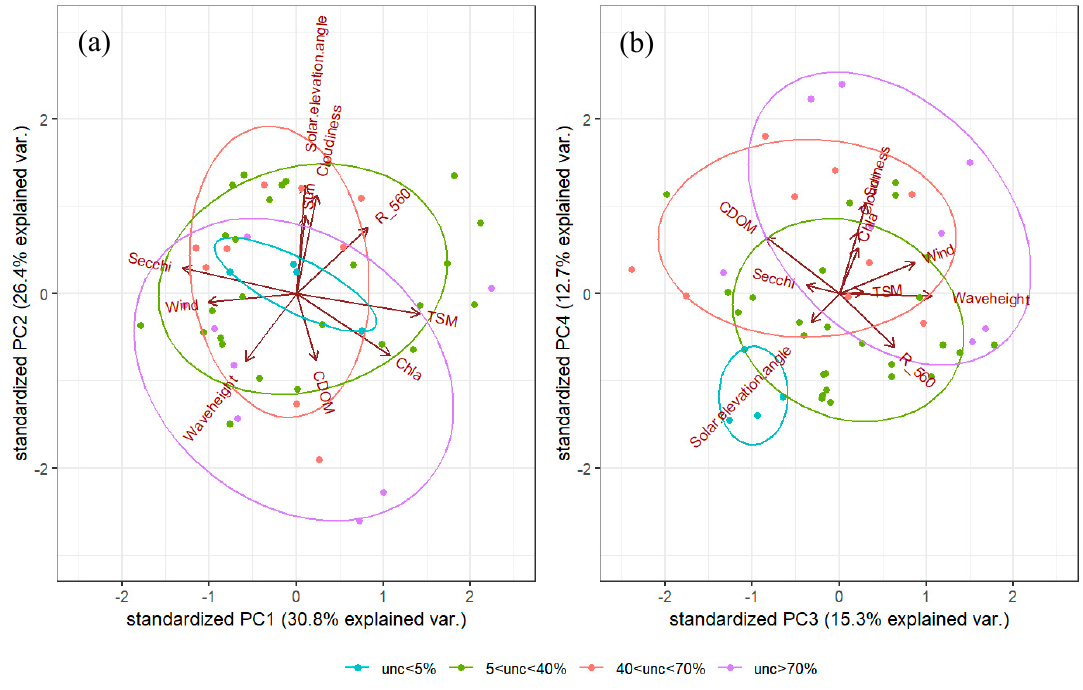
Figure 3. Each data point from the in situ dataset is positioned in terms of the first four principal components (PC) and associated level of uncertainty estimated at the 442 nm band. The clusters based on the uncertainty are shown on ( a ) for PC1 and PC2 and on ( b ) for PC3 and PC4. Based on PC3 and PC4, different clusters were formed in terms of low (<5% uncertainty at the 442 nm band) and high (>70% uncertainty at the 442 nm band) measurement uncertainty (Figure 3). Both PC3 and PC4 are determined by environmental conditions. The main contribution to PC3 comes from wave height and wind speed, to PC4 from sun conditions (if there are clouds in front of the sun or not) and overall sky cloudiness (Table 2). Based on the PC3 and PC4, measurements with a lower level of uncertainty are associated with lower wave height and wind speed (PC3) and also good illumination conditions (clear sky and no clouds in front of the sun) (PC4).